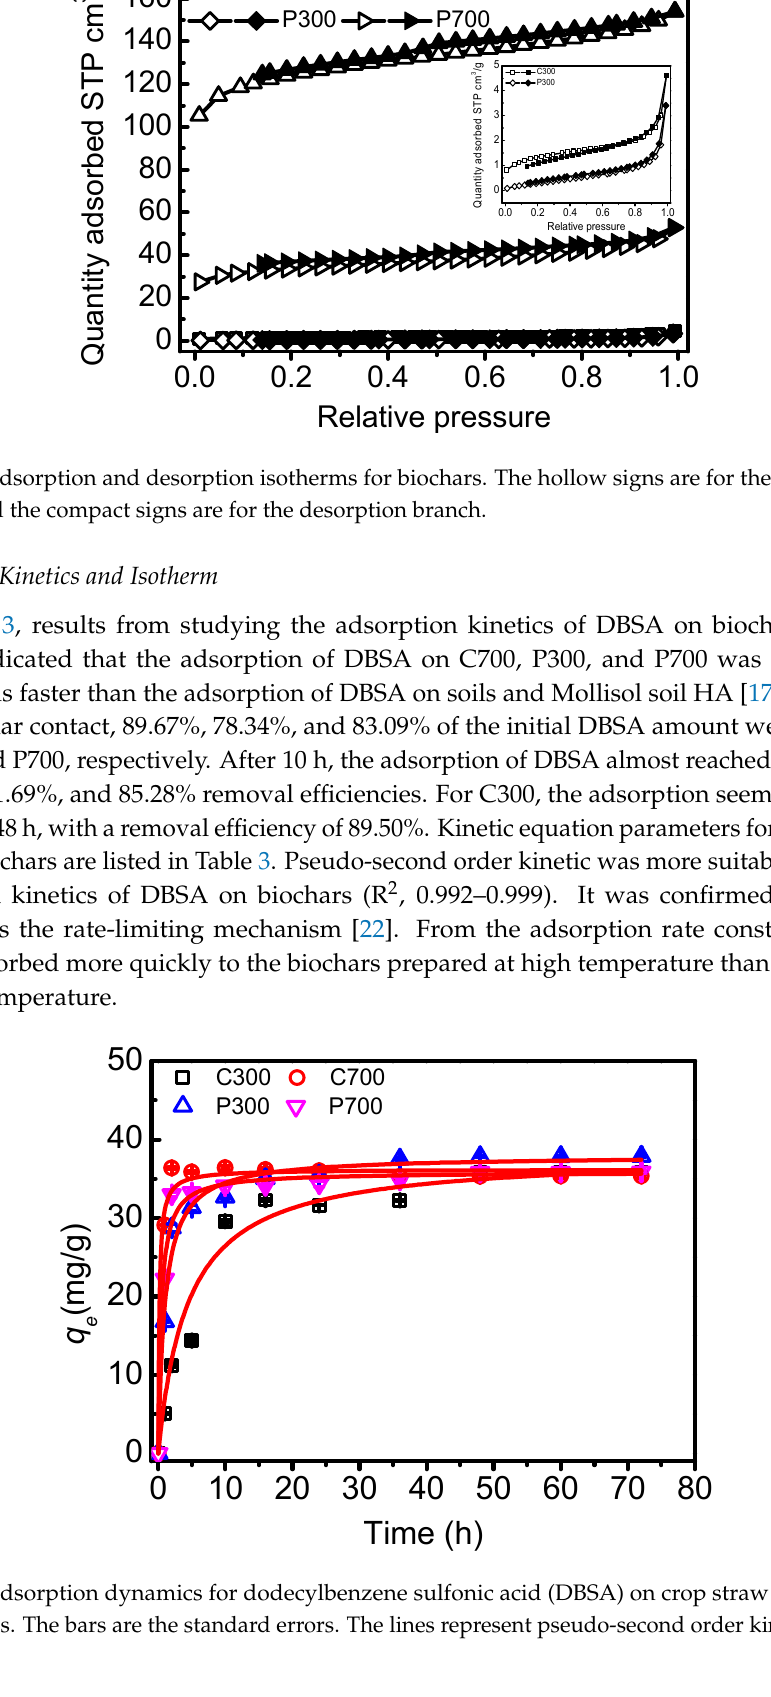
Figure 1. Scanning electron microscope images of C300 ( a ); C700 ( b ); P300 ( c ); and P700 ( d ).